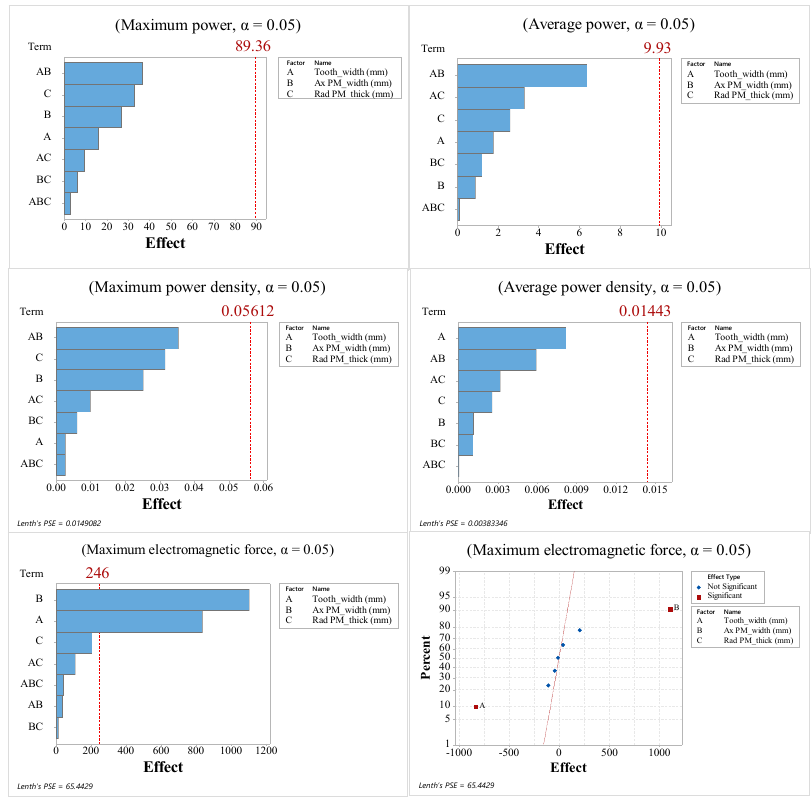
Figure 8. Effects of the three factors on the machine’s performance. Figure 8. E ff ects of the three factors on the machine’s